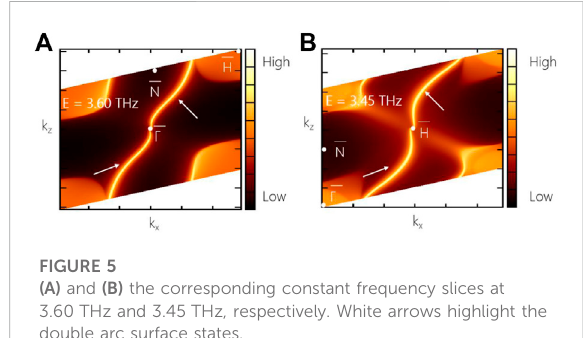
FIGURE 5 (A) and (B) the corresponding constant frequency slices at 3.60 THz and 3.45 THz, respectively. White arrows highlight the double arc surface